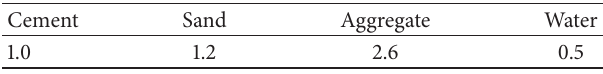
Table 1: Proportions of concrete mixture. Table 2: Compressive strength for the cylindrical